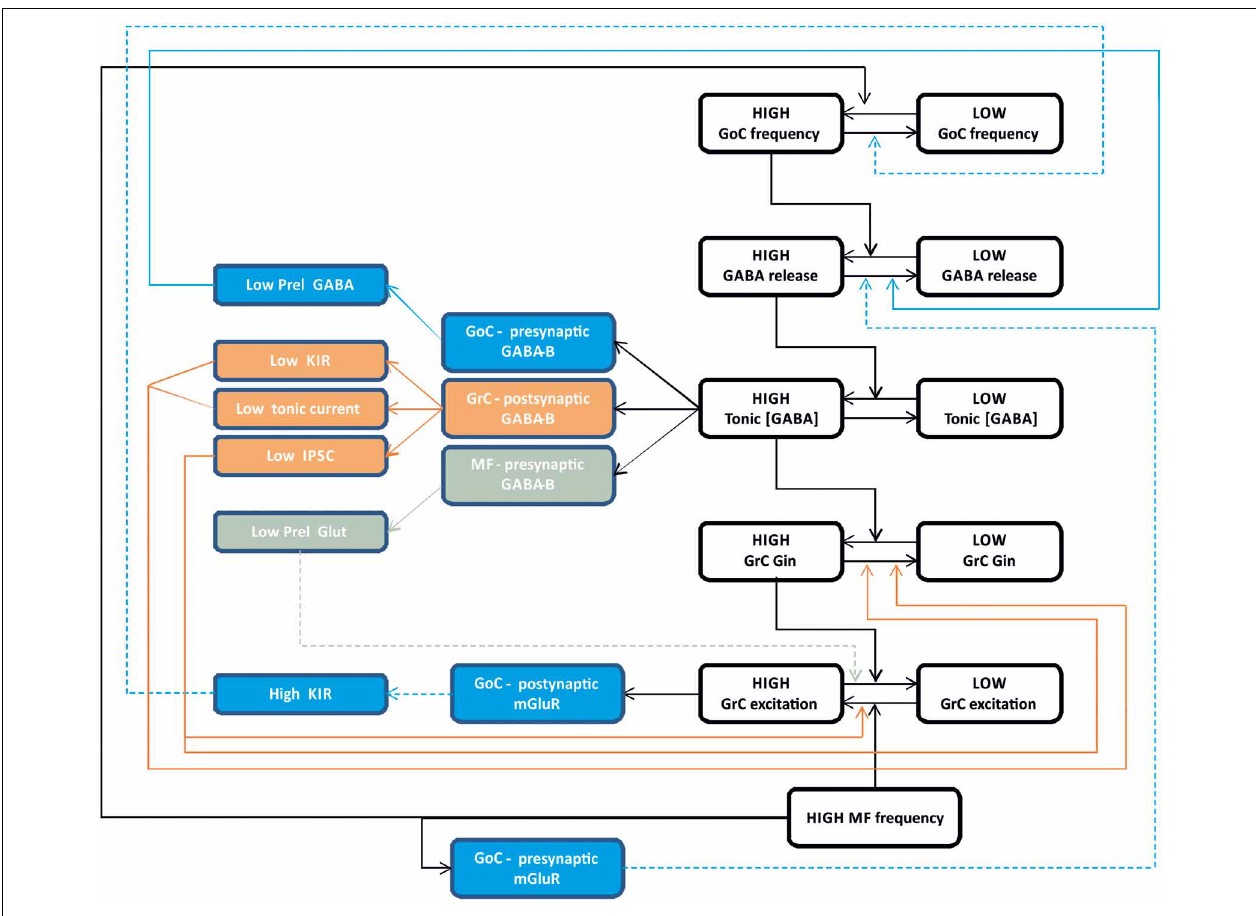
FIGURE 6 | Integratedcontrolofinhibitioninthegranularlayercircuit. The flow chart represent the glomerular interaction of excitatory and inhibitory mechanisms, converging onto granule cells. The colored boxes on the left represent the modulating (dashed lines) and homeostatic (solid lines) effects